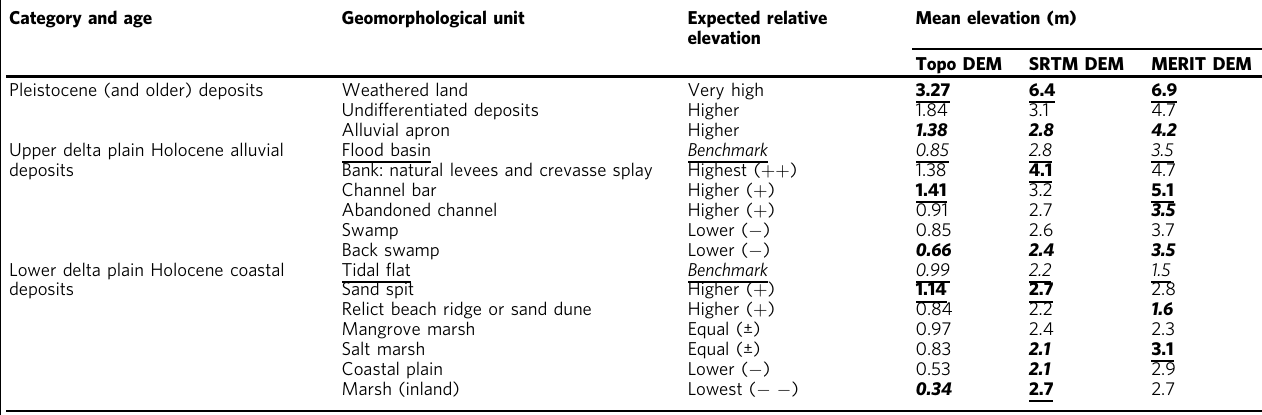
Table 2 Elevation comparison of geomorphological units in the Mekong delta Category and age Pleistocene (and older) deposits